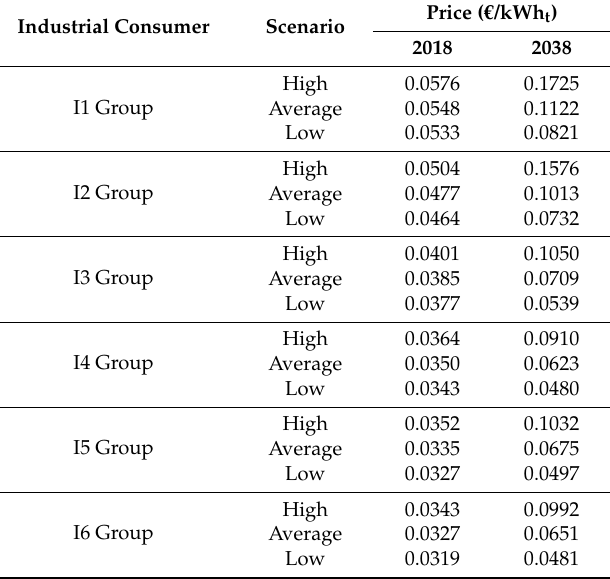
Table 8. Natural gas price forecast, 2018–2038.